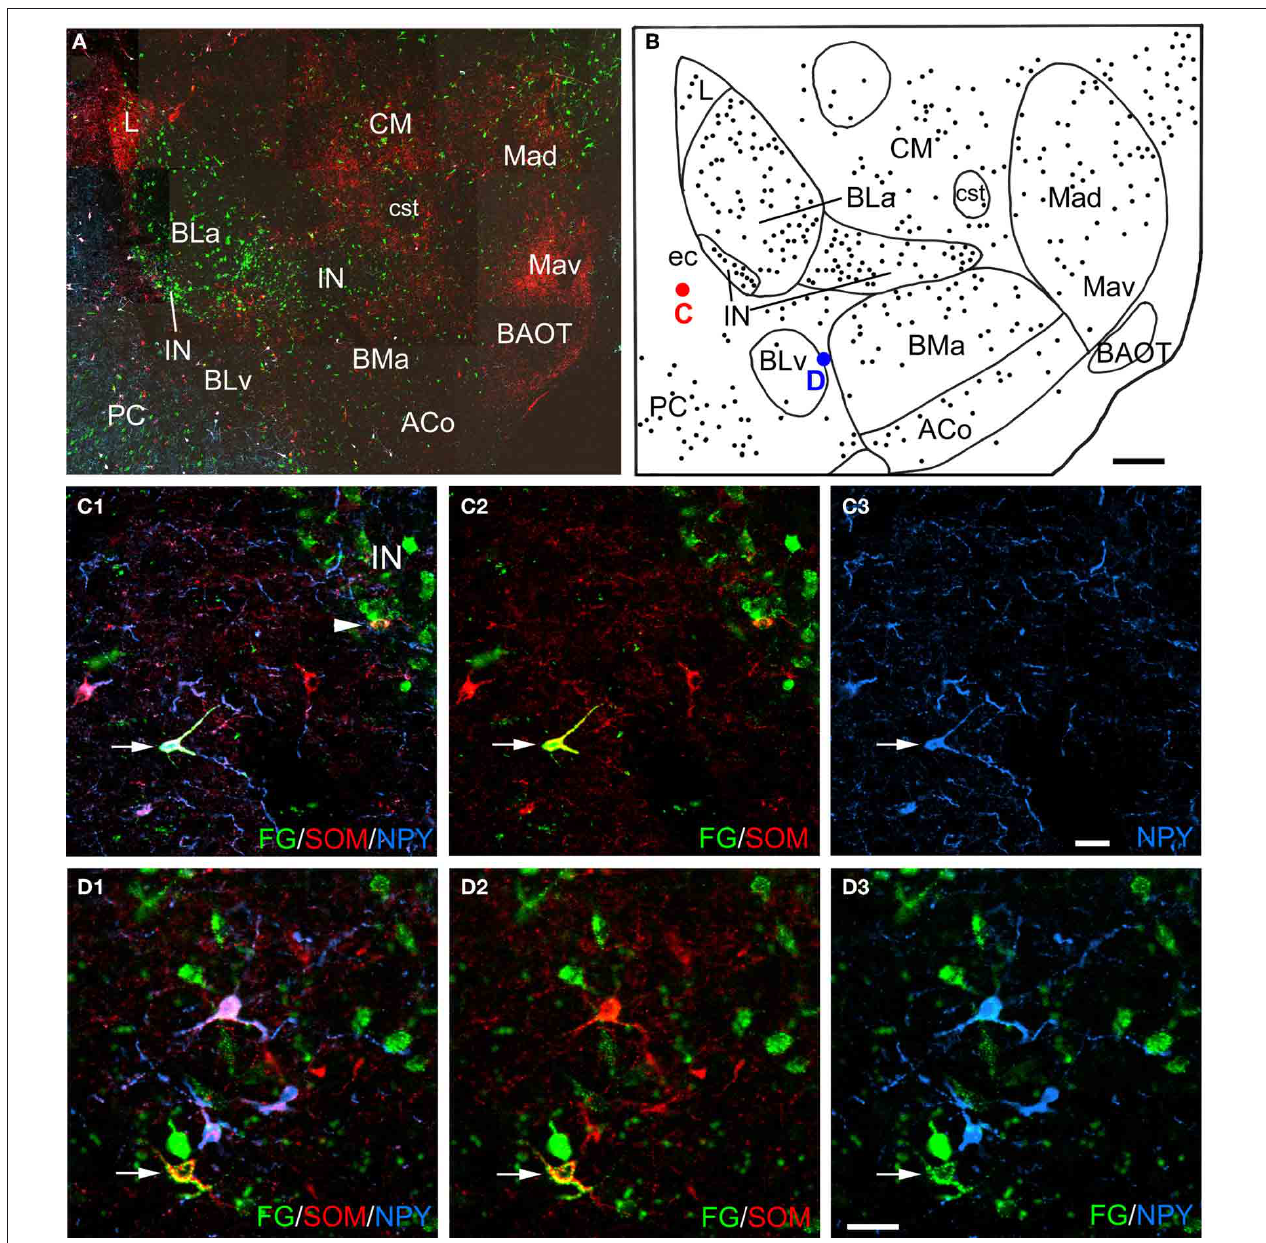
FIGURE 2 | (A) Low power photomontage of a coronal section through the rostral amygdala (Bregma − 2.1) in case R7 that was triple-labeled for FG (green), SOM (red), and NPY (blue). Lateral is left. After this section was analyzed the coverslip was removed and the section was counterstained with pyronin Y. This allowed the nuclear borders to be more precisely defined, as depicted in B . (B) Drawing of the distribution of FG-labeled neurons seen in A , created by overlaying a plot of FG-labeled neurons in this section over a drawing of the nuclei identified after counterstaining. The positions of a triple-labeled FG/SOM/NPY + neuron in the external capsule (ec, red dot), and a FG/SOM + neuron located between the ventral basolateral nucleus (BLv) and the anterior basomedial nucleus (BMa) that was NPY-negative (blue dot) are indicated. (C1–C3) Photomicrographs of the FG/SOM/NPY + neuron shown in red in B (arrow). Also note a FG/SOM + neuron (yellow) that was NPY-negative at the lateral edge of the lateral intercalated nucleus (IN; arrowhead in C1 ). (C1) Merged image visualizing all three channels.